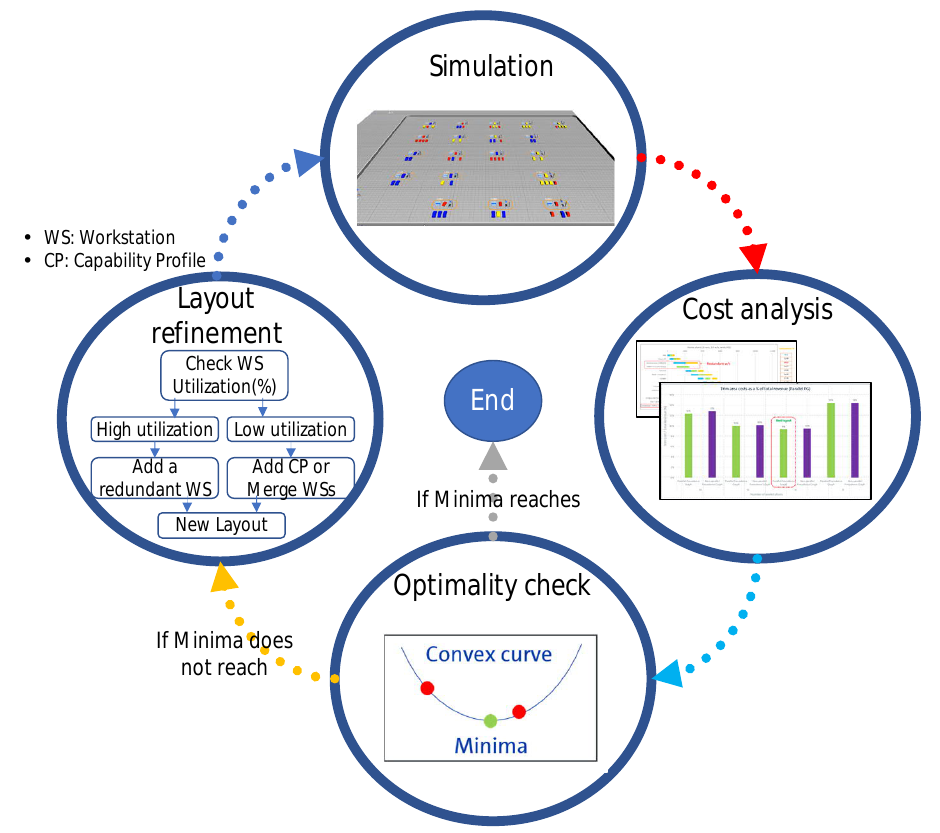
Figure 9. Iterative design process to find optimal matrix assembly system.